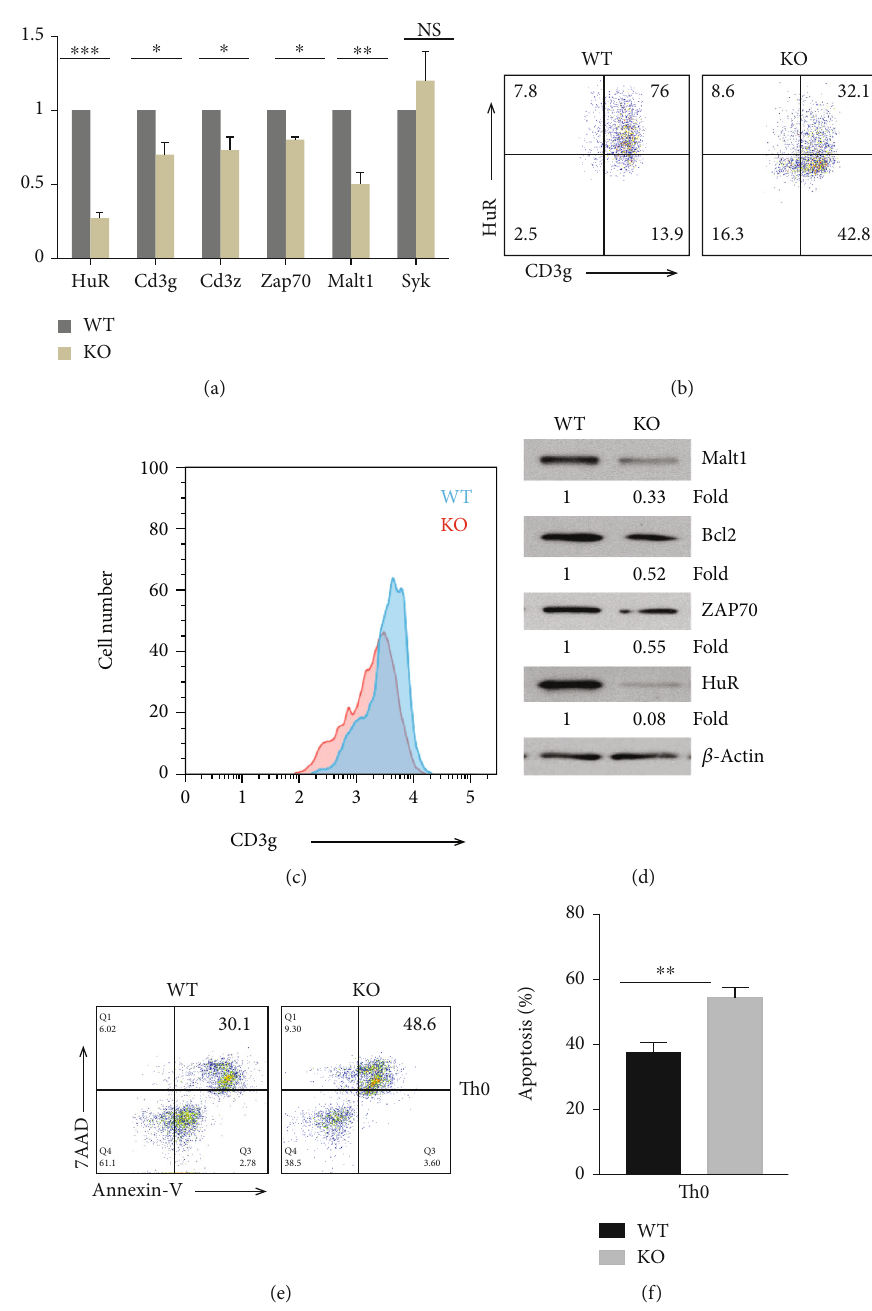
Figure 1: HuR modulates TCR/CD3 complex signaling and protects activated CD4 + T cells from apoptosis. Naïve CD4 + T cells from the spleen of WT and HuR KO mice were isolated and cultured under Th0 cell polarization conditions as described in Materials and Methods. The polarized cells were collected for further experiments at 5 days after culture. (a) Total RNAs were extracted and transcribed into cDNA. mRNA levels were analyzed by RT-qPCR. (b, c) Expression of HuR and Cd3g was measured by fl ow cytometric analysis at 4 days of Th0 culture. One of the three repeat experiments is shown. (d) Knockout of HuR decreased abundance of Zap70, Malt1, and Bcl- 2, as detected by western blot assay. (e) HuR KO Th0 cells were more susceptible to apoptosis than WT Th0 cells as determined by fl ow cytometry assay. (f) Summary of three independent experiments is shown for detecting apoptosis by fl ow cytometry analysis. Data in (a) represents the summary of three independent experiments ( mean ± SEM ). Data in (b) – (e) represent one of the three independent experiments. Data in (f) represent the summary of the three independent experiments ( mean ± SEM ) of Th0 cell apoptosis fl ow cytometric assay. Student ’ s t -test was used for statistics analysis. ∗ p < 0 : 05 and ∗∗ p < 0 : 01